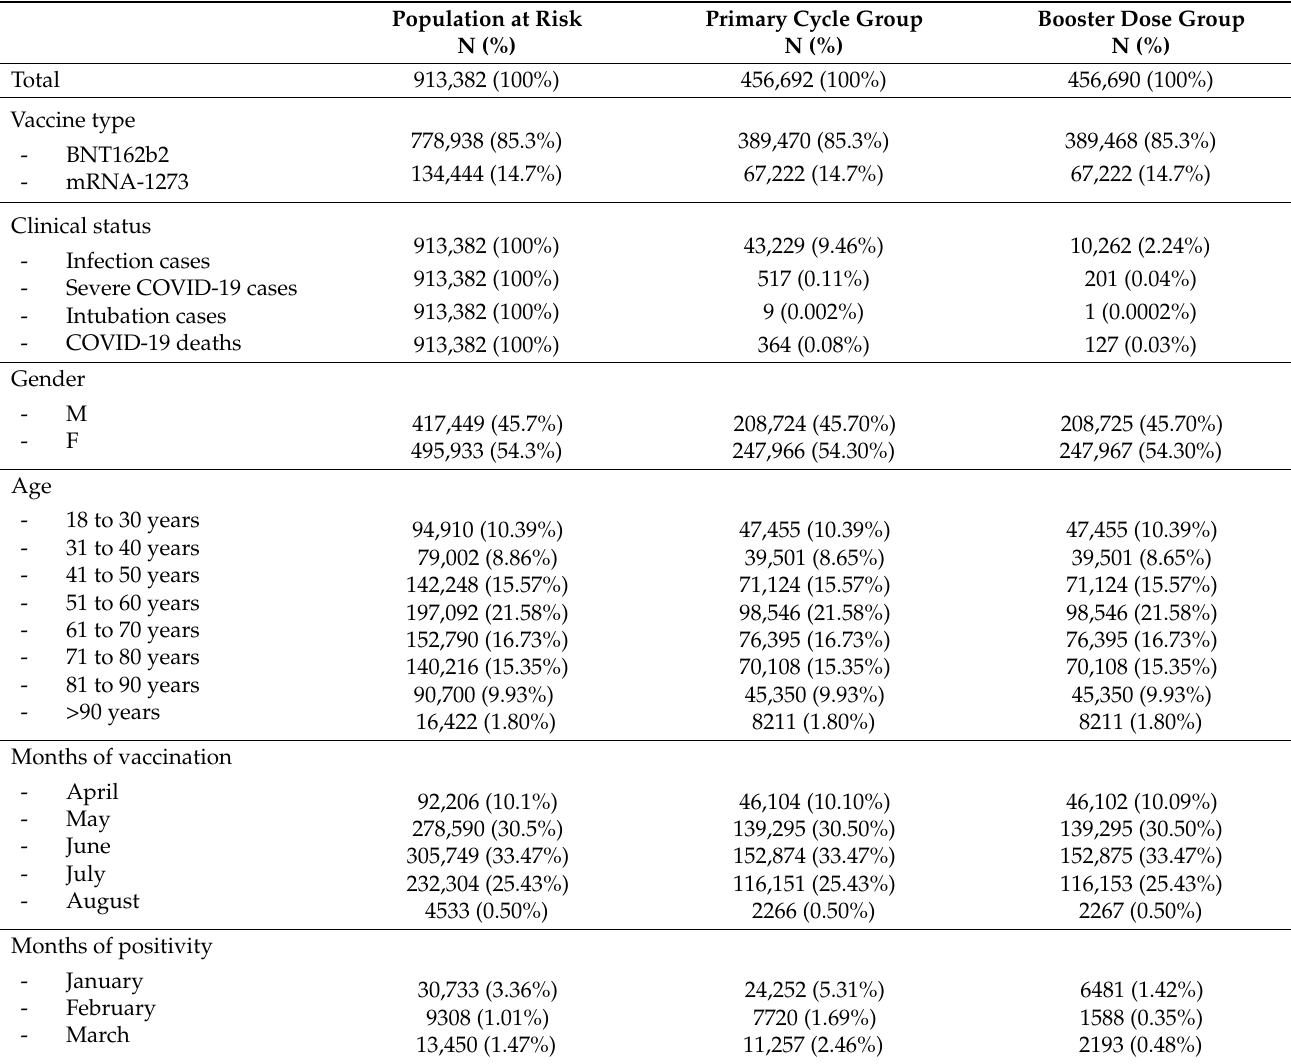
Table 1. Characteristics of the cohort of 913,382 vaccinated subjects aged 18 years or more who re- ceived at least a primary mRNA vaccine cycle and were followed up from 1 January to 31 March 2022. Population at Risk Primary Cycle Group Booster Dose N (%) N (%)